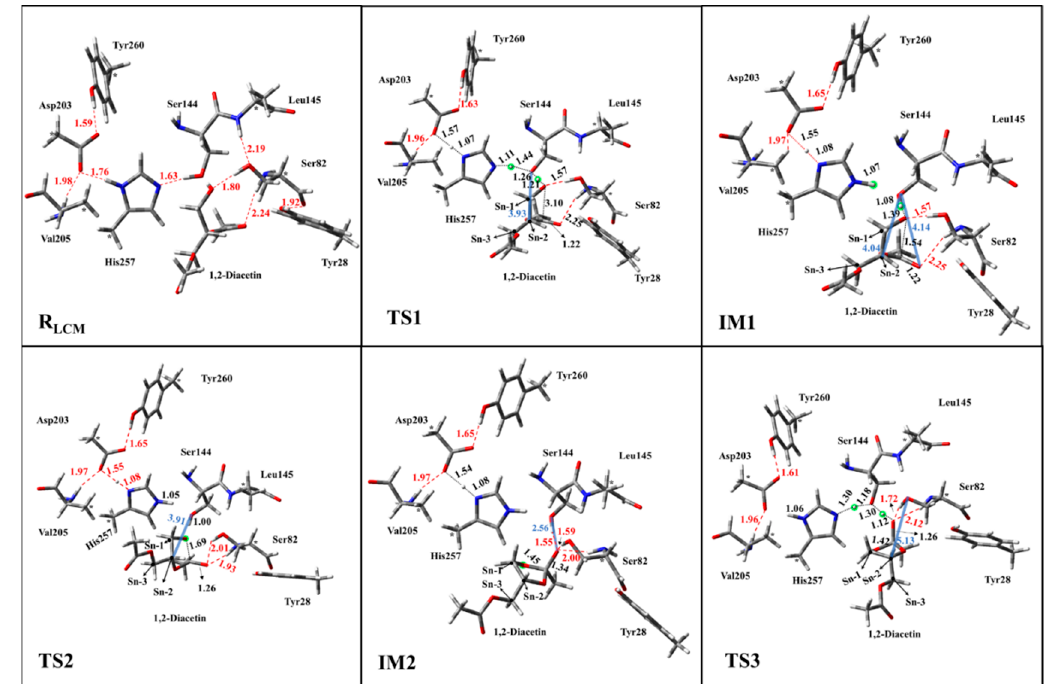
Figure 5. Optimized structures of the reactant (R LCM ), transition state (TS1, TS2, TS3), intermediate (IM1, IM2) of the enzyme-substrate complex in the LCM of the AM. Red dashed lines represent the hydrogen bond. The hydrogen bond distances are represented by the red dashed line, the distance between substrate and catalytic triad are marked as the blue solid line, all distances are given in angstroms, and the asterisks (*) stand for the fix atoms during geometry optimization.